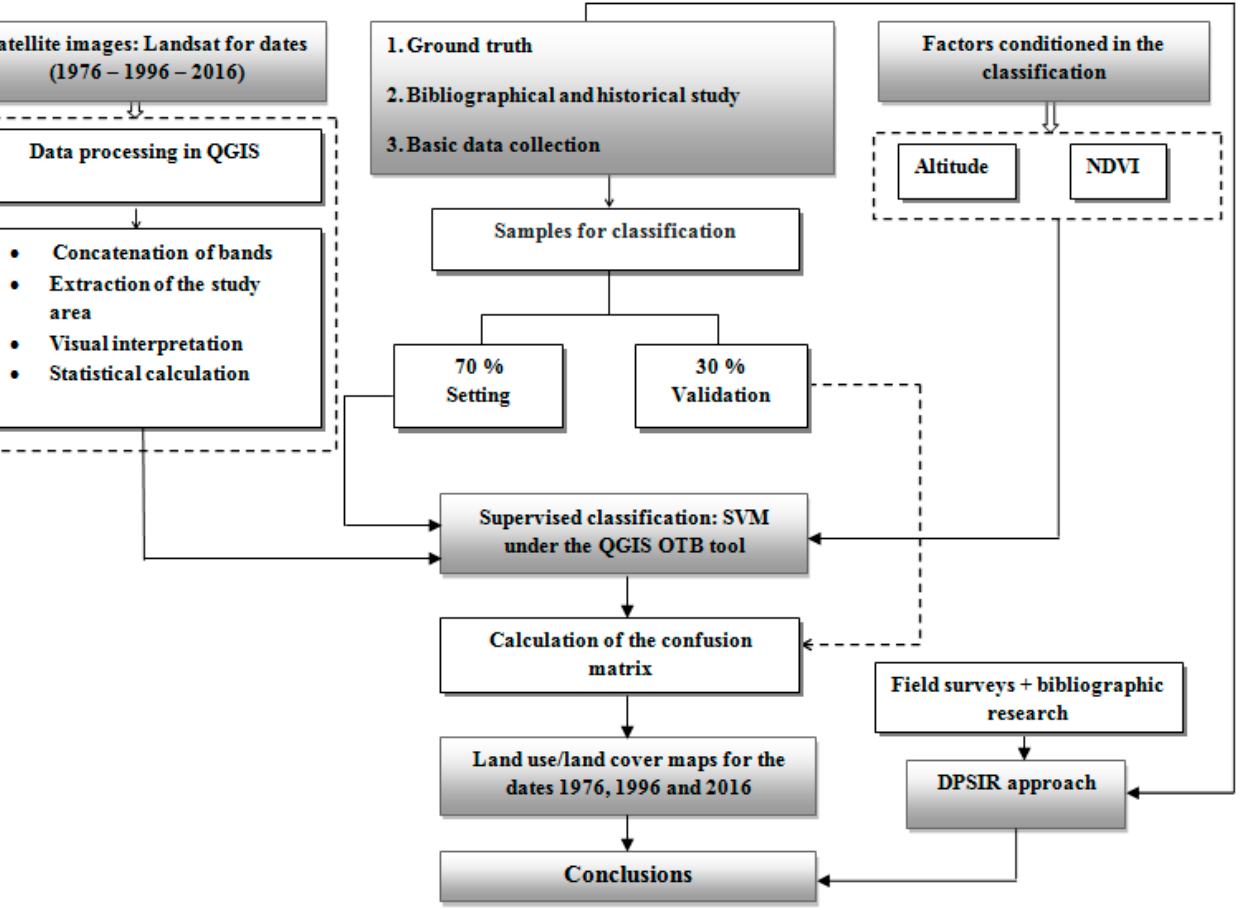
Figure 2. Schematic of the methodological approach adopted for the diachronic analysis of the dy- namics of land use/land cover for the study period (1976–2016). dynamics of land use/land cover for the study period